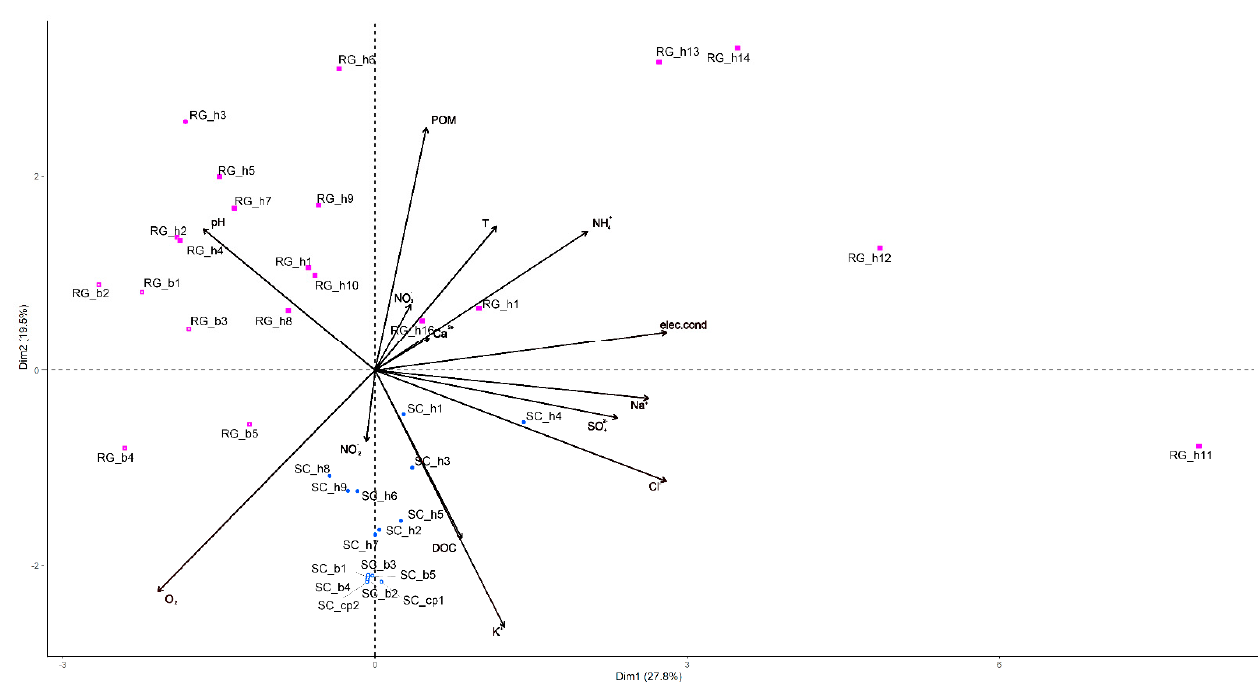
Figure 4. PCA biplot for the physical and chemical parameters measured in Rio Gamberale and Stiffe Cave. Abbreviations used: RG = Rio Gamberale stream; SC = Stiffe cave; RG_b = Rio Gamberale stream benthic site; RG_h = Rio Gamberale stream hyporheic site; SC_b = Stiffe Cave benthic site; SC_h = Stiffe Cave hyporheic site.